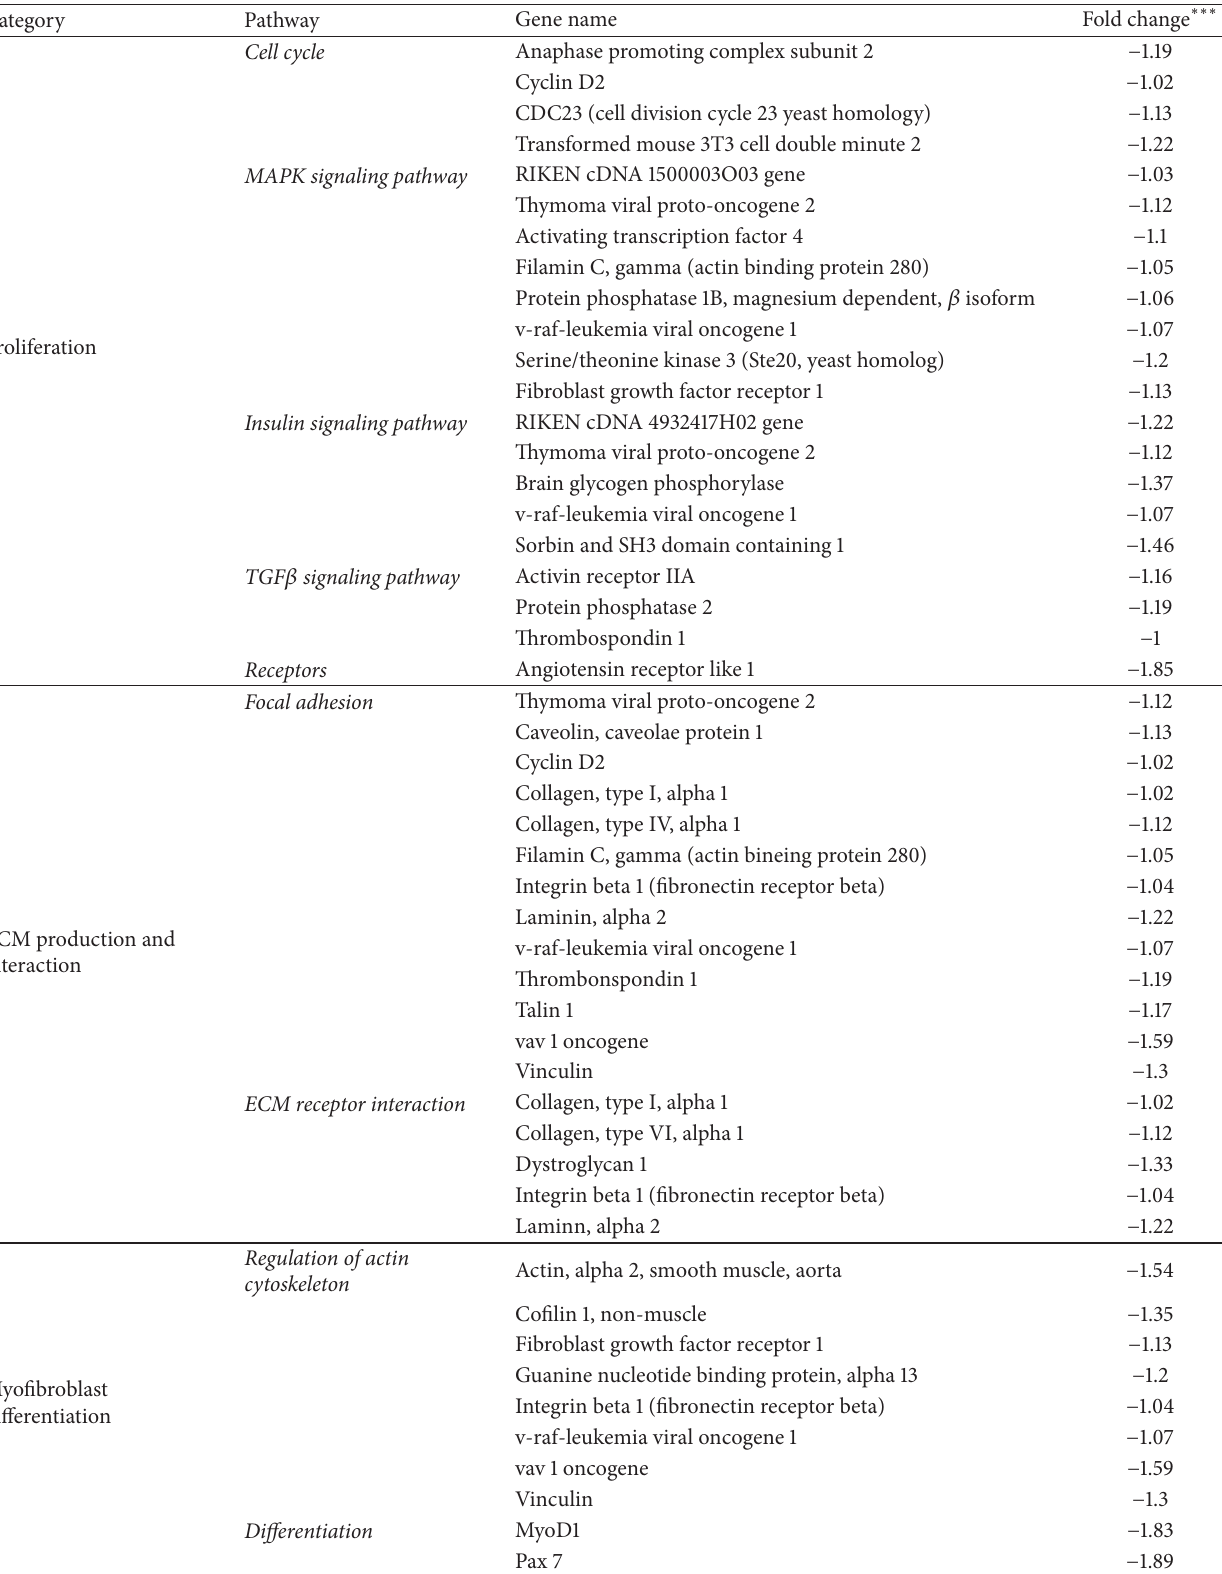
Table 3: Pathways involved in myofibroblast proliferation, differentiation, and interaction with the ECM and immune system that are affected by